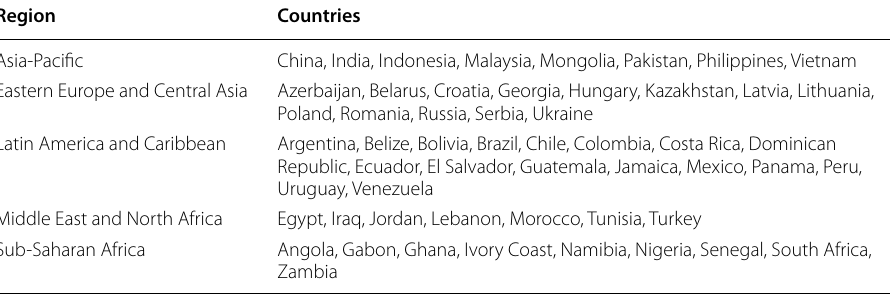
Table 2 List of included countries and region classification